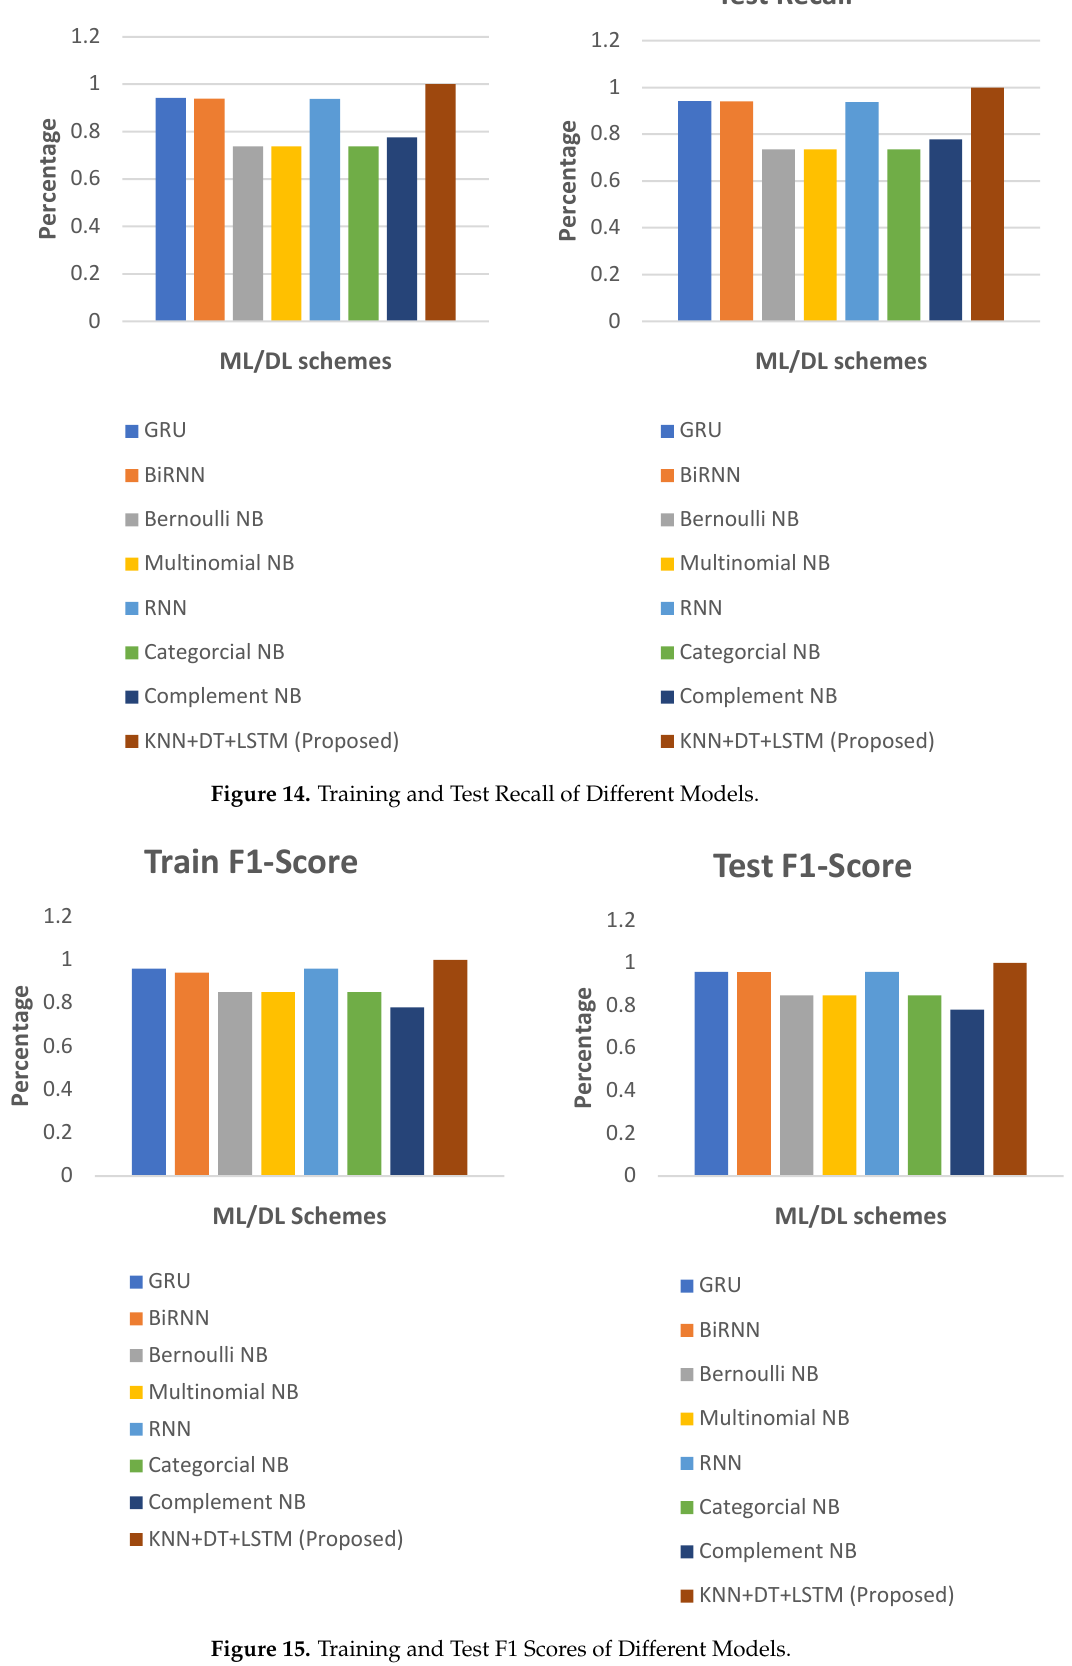
1 Table 3. Performance Metrics of Different ML/DL Schemes (Test). Techniques